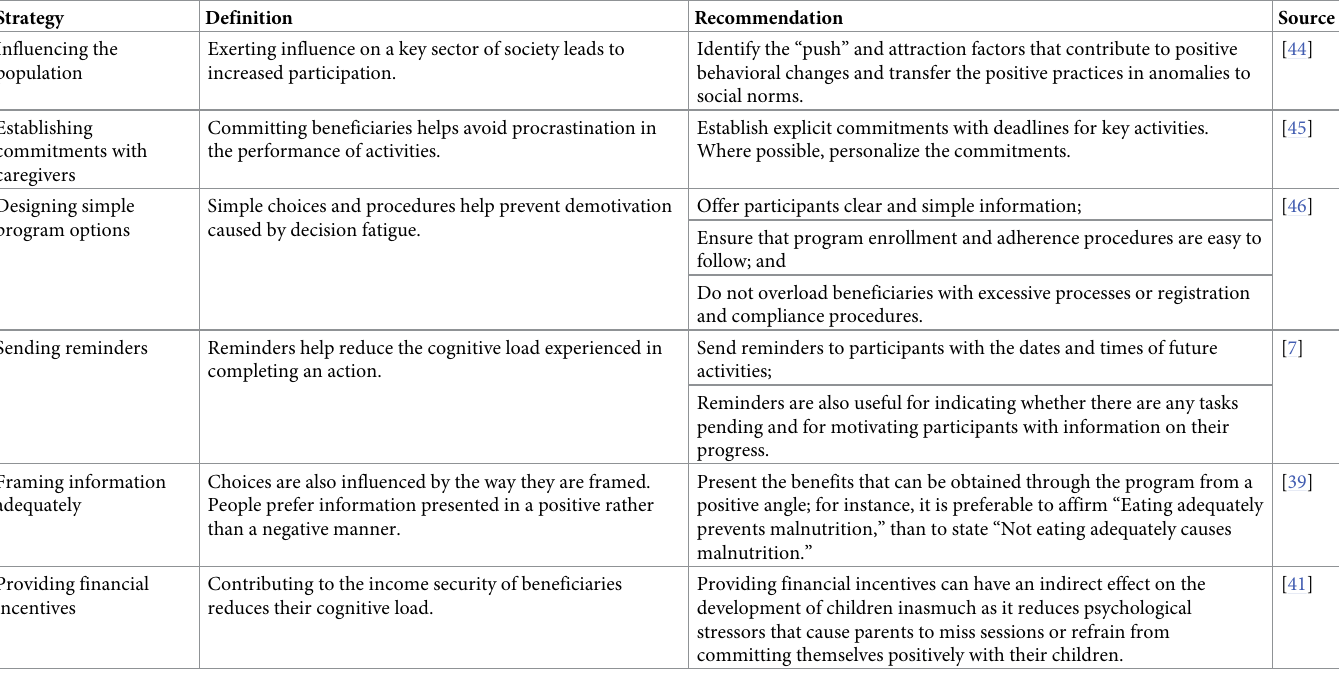
Table 2. Strategies identified in the literature for promoting participation in social programs.